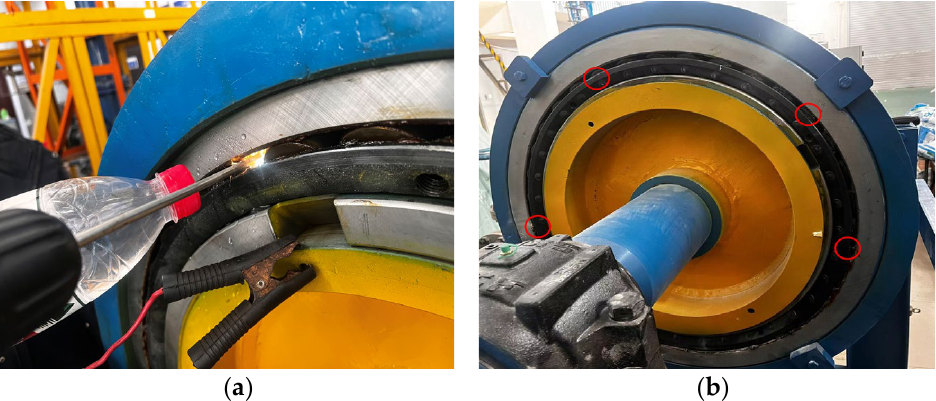
Figure 5. SKF 3519/560/HCYA6: ( a ) rolling element damage with 2 mm diameter and 0–5 mm depth; ( b ) multirolling element damage with 2 mm diameter and 0.5 mm depth.